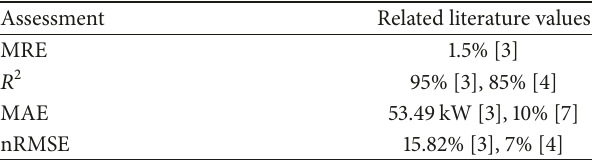
Table 3: A table defining the variables used as inputs to the ANN.